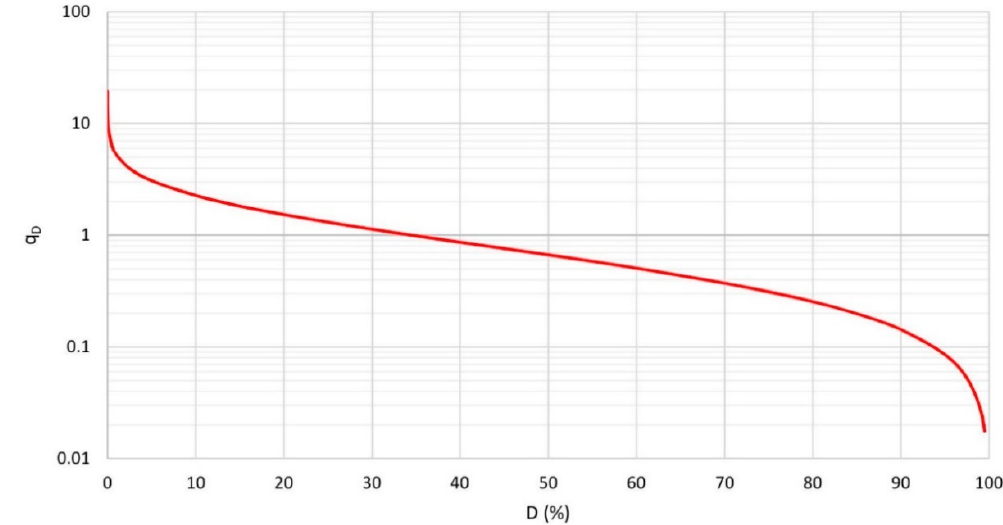
Figure 6. The nondimensional FDC of the Ceyhan River basin.